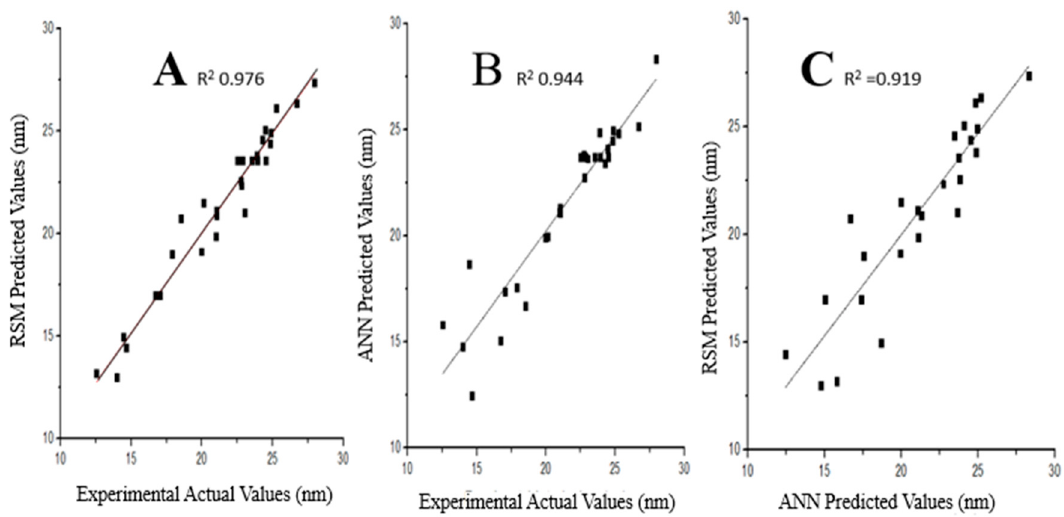
Figure 5. Parity plots; ( A ) Response Surface Methodology (RSM) predicted against experimental actual values. ( B ) Artificial Neural Network (ANN) predicted against experimental actual values. ( C ) RSM predicted values against ANN predicted values. Table 8. Artificial neural network (ANN) optimum values for hidden layer sizes and corresponding transfer functions (‘tansig’ and ‘logsig’) for minimum error fittings for train, validation, and test of optimized RSM data. Train Hidden Neurons